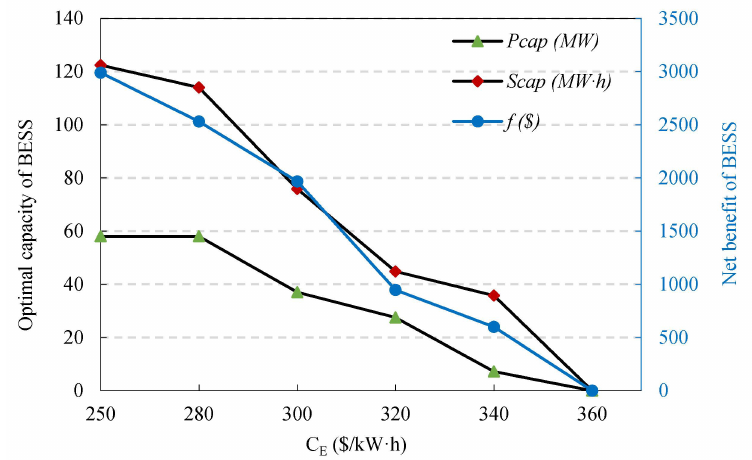
Figure 8. Optimal results under different investment costs of BESS. C E : unit capacity cost of BESS.